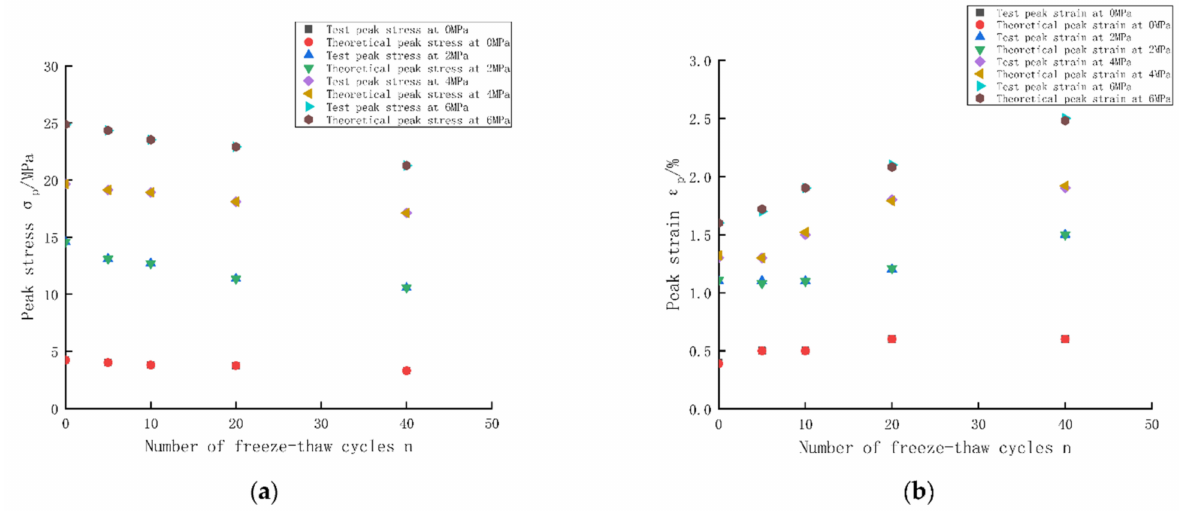
Figure 2. ( a ) Peak stress of different freeze-thaw cycles under the same confining pressure. ( b ) Peak strain of different freeze-thaw cycles under the same confining pressure.